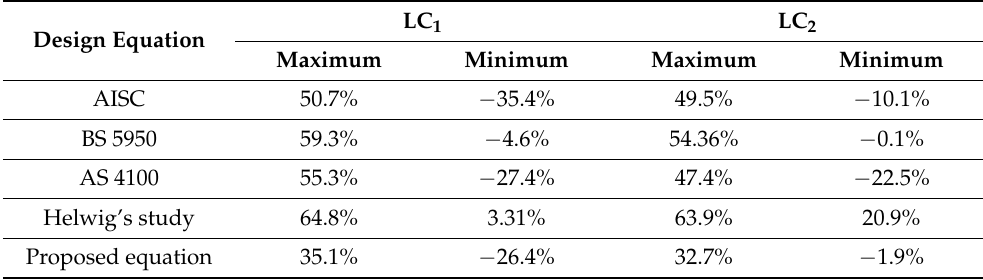
Figure 11. Comparison of elastic critical LTB between FEA results and proposed equations. ( a ) LC 1 , ( b ) LC 2 . Table 4. Differences in elastic critical LTB between FEA and considered equations.